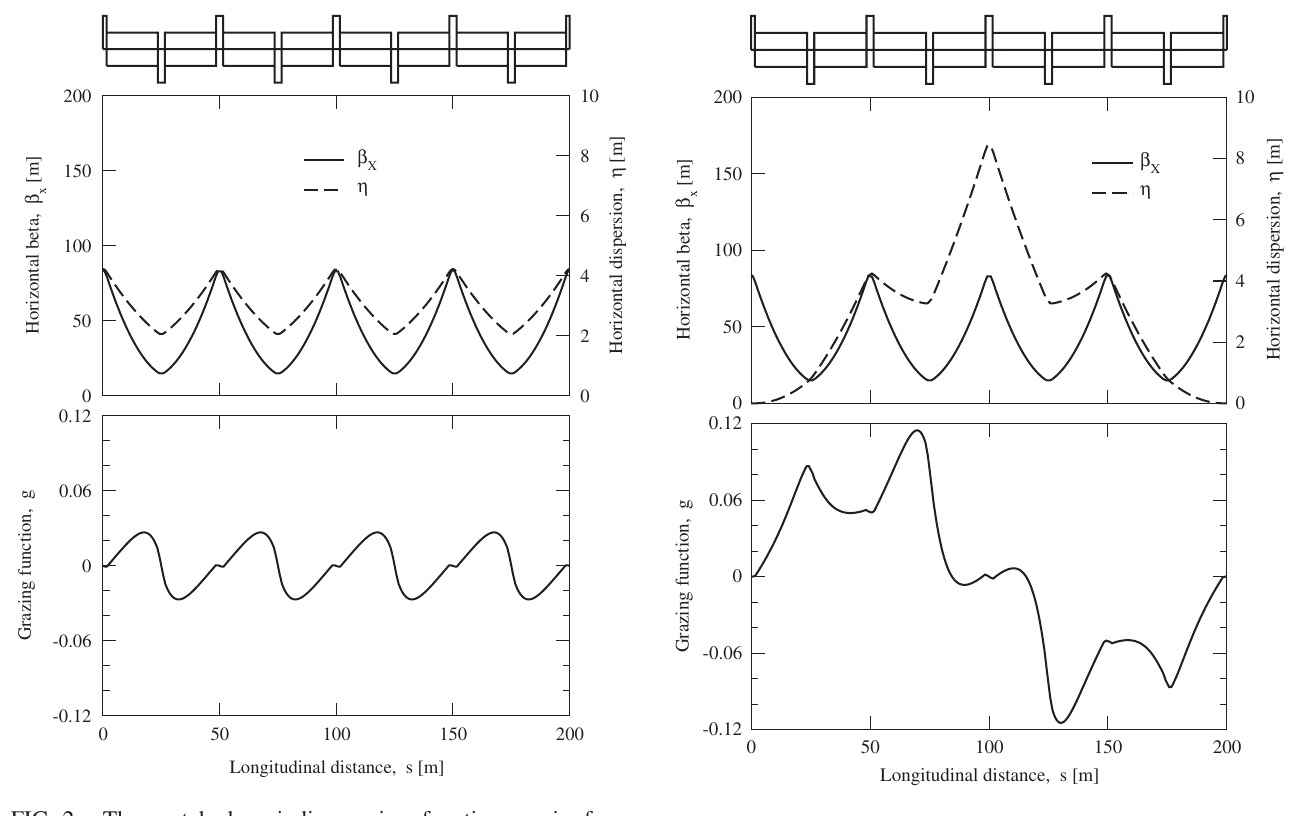
in four FIG. 3. The grazing function in the presence of a 100% dis- P persion wave, dominated by the 1 (cid:4) harmonic and modulated by ffiffiffiffi p (cid:1) 1 = , with a maximum g value of 0.115 that is 4 times the maximum in the matched case. The thin quadrupole prediction of 0.0498 at s ¼ 50 m agrees well with the actual value of 0.0508.